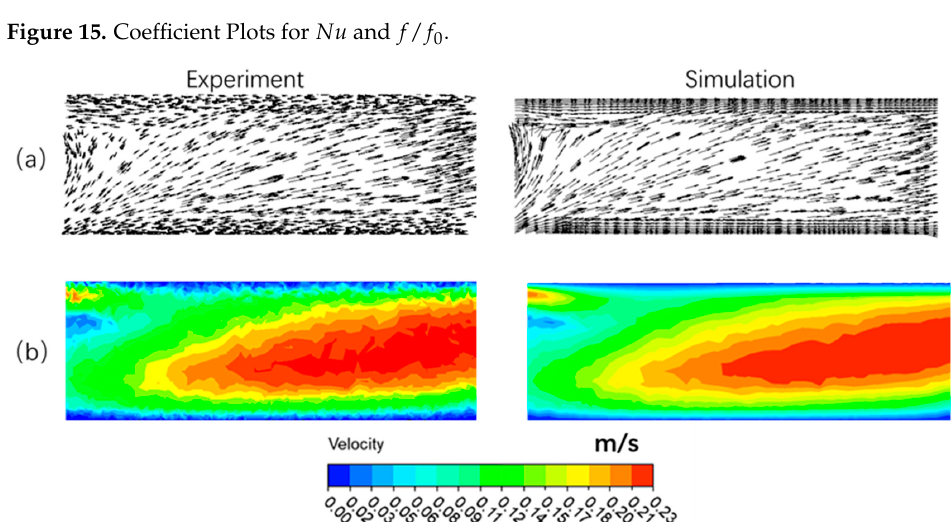
Figure 15. Coefficient Plots for Nu and f / f 0 .